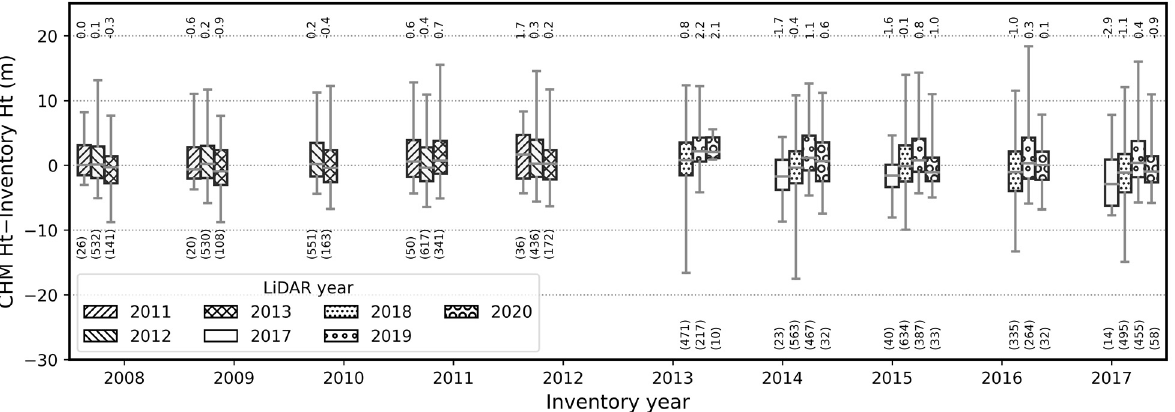
Figure 15. Height measurement error with respect to inventory and LiDAR acquisition year. Boundaries of upper and lower whisker is the ninety-seventh and third percentiles. The number above each box plot is median, and the number below box plot is number of data points. CHM: canopy height model; Ht: height.